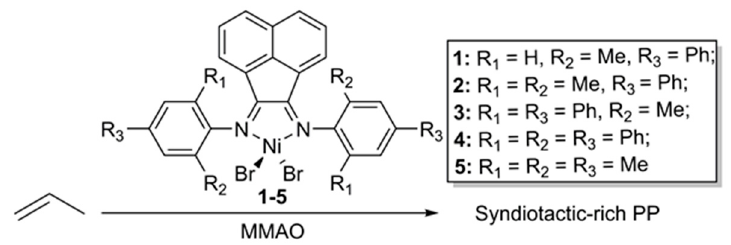
Scheme 2. Chain - walking polymerization of propylene catalyzed with α - diimine nickel catalysts 1–5 .